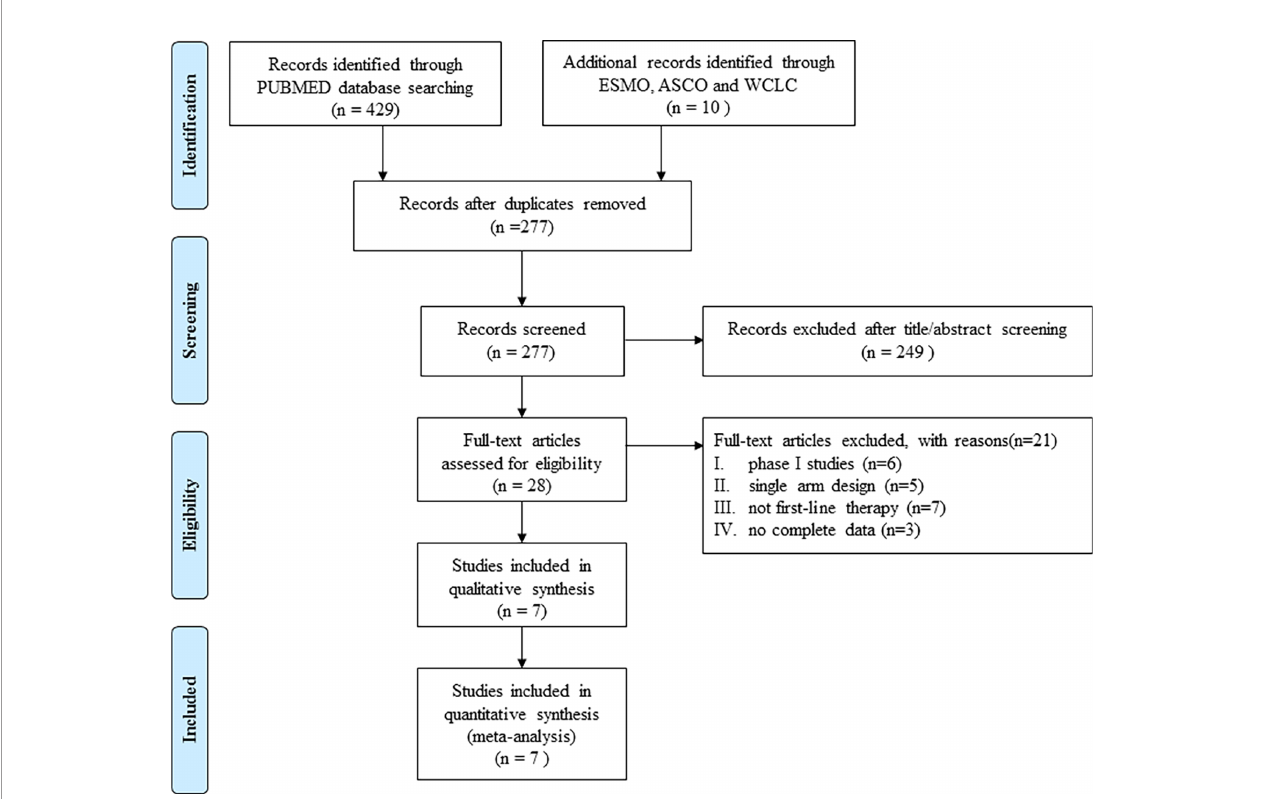
FIGURE 1 | Flowchart of study inclusions and